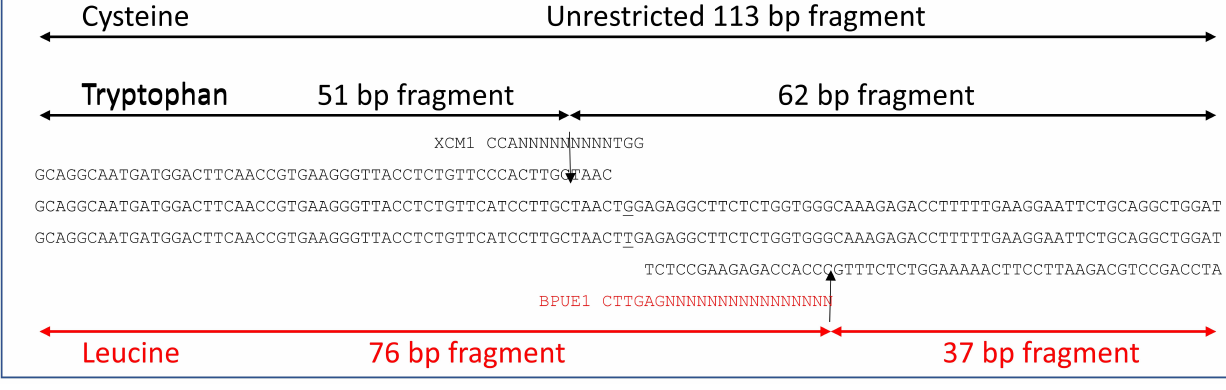
Figure 2. 2027-ACCase-derived Polymorphic Amplified Cleaved Sequence assay: primer sequence, discriminating restric- tion enzymes, and expected PCR-RFLP profiles. The wild-type tryptophan allele will show two fragments of 51 and 62 base pairs and the mutant leucine allele will be manifested by two fragments of 76 and 37 base pairs. A mutant cysteine allele will result in an unrestricted band of 113 base